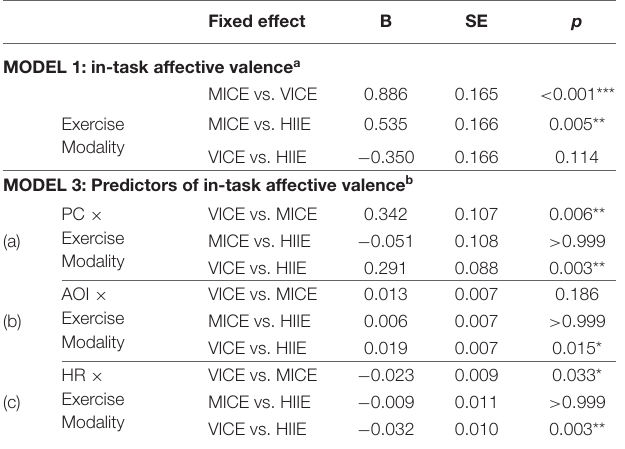
TABLE 3 | Associations of exercise modality and psychophysiological factors with affective valence.